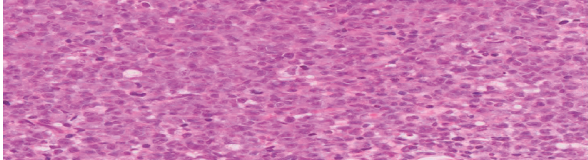
Figure 7: High-power view of transformed lymphoid cells and mitoses. HEx400x.